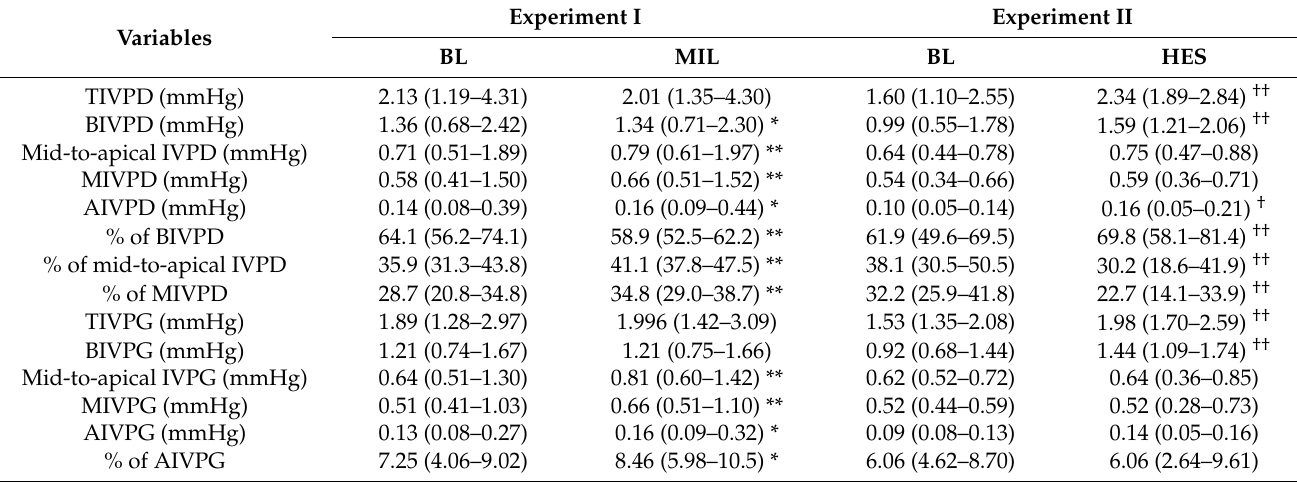
Table 2. Changes in IVPD and IVPG under various loading conditions